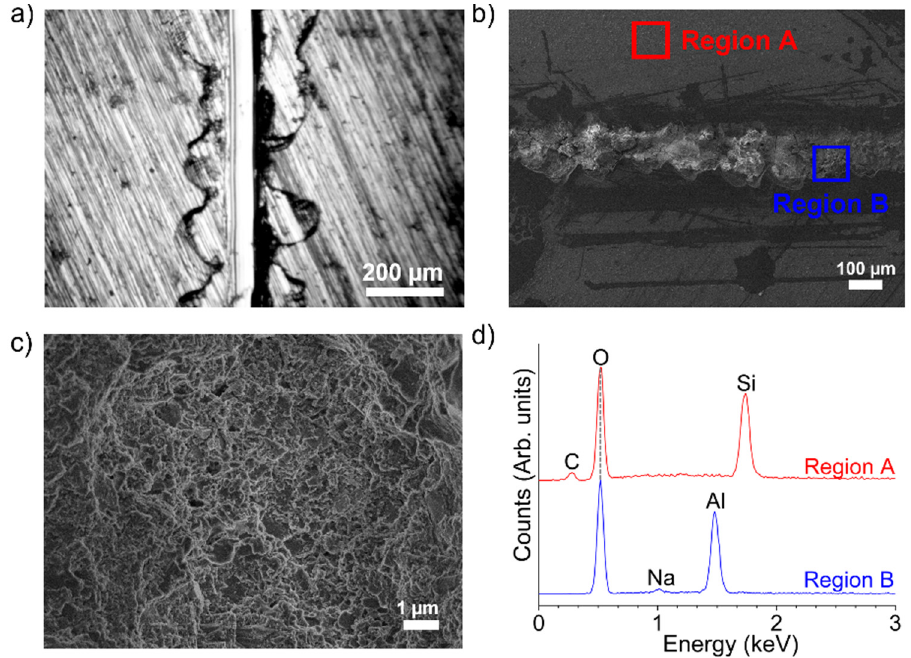
Figure 10. ( a ) Optical micrograph of the scratched Li2 coating before immersion, ( b – c ) SEM images of the scratch after 21 days of exposure to 3.5% NaCl obtained at increasing magnifications, and ( d ) EDS spectra of the corrosion products in the scratched region.